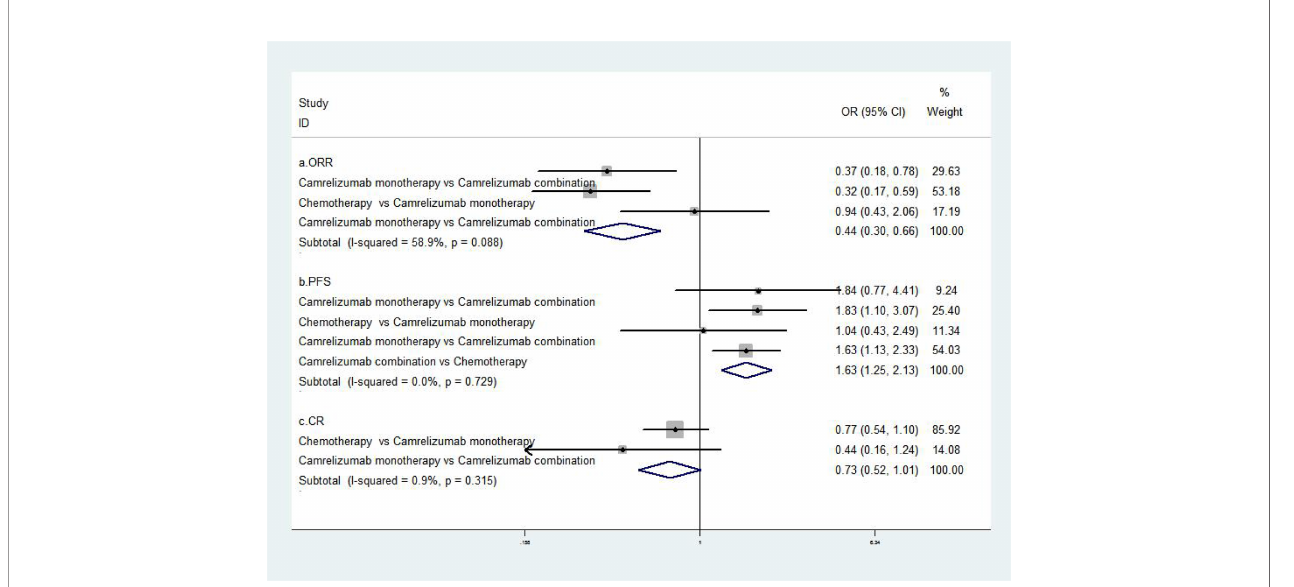
FIGURE 2 | Meta-analysis of ef fi cacy of single and combined treatment of